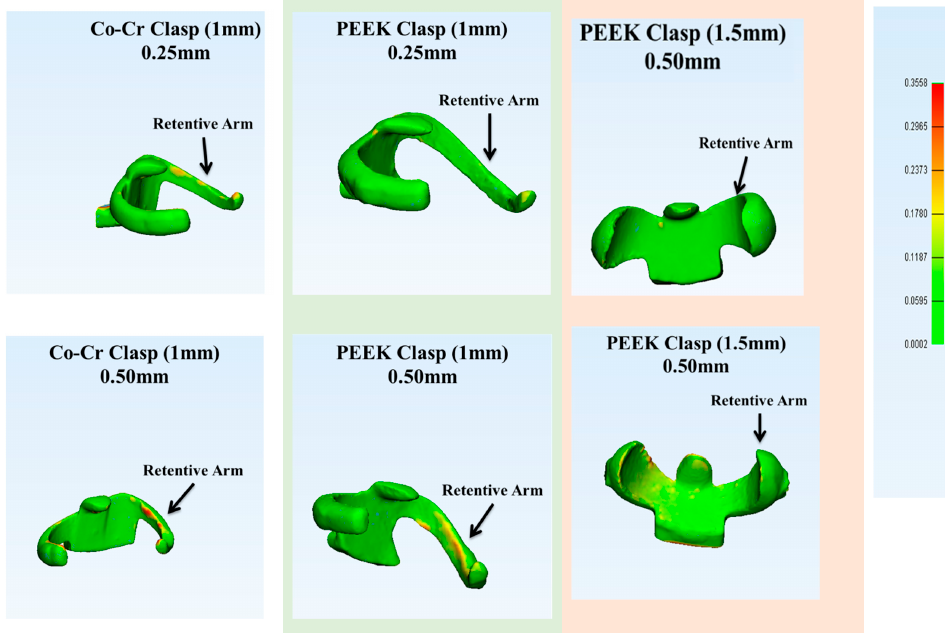
Figure 7 . From the right, the standard reading was fixed from 0.0002 mm ( green color ) to 0.3558 mm ( red color ). The upper part of the photo shows the clasps with 0.25 mm; the lower part shows clasps with 0.50 mm undercut.